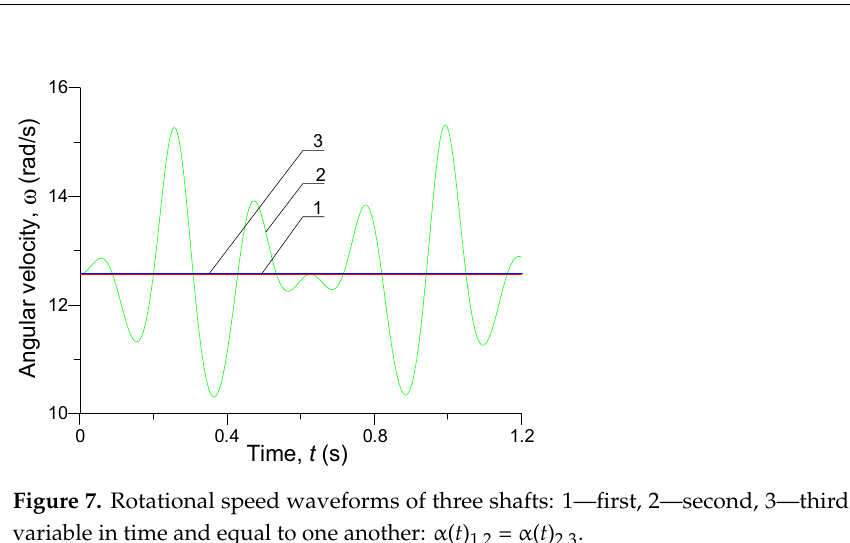
( b ) Figure 9. Angular velocity of two shafts versus time for the α 1,2 = α 2,3 = π /5 and shaft diameter: ( a ) D = 0.1 m; ( b ) D = 0.192 m.